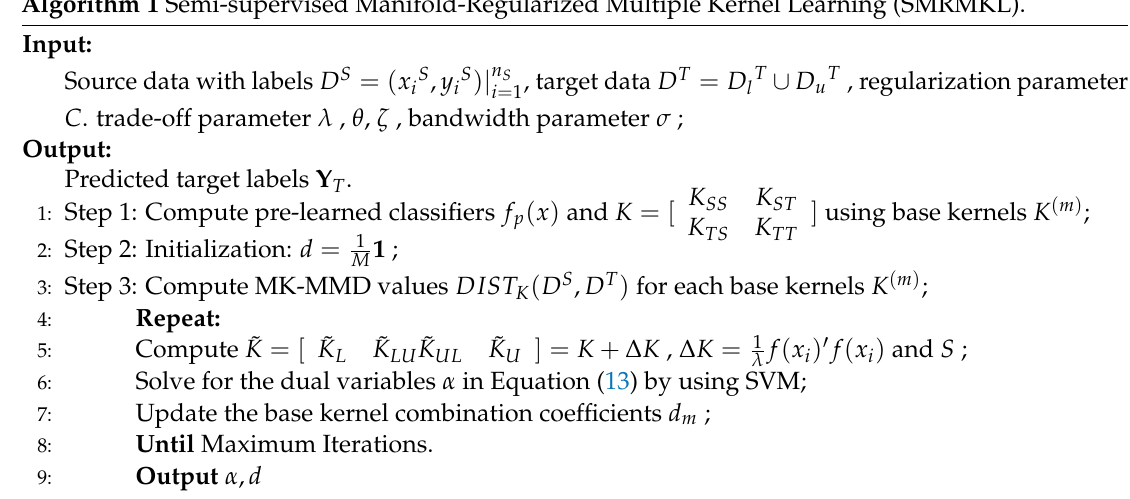
Algorithm 1 Semi-supervised Manifold-Regularized Multiple Kernel Learning